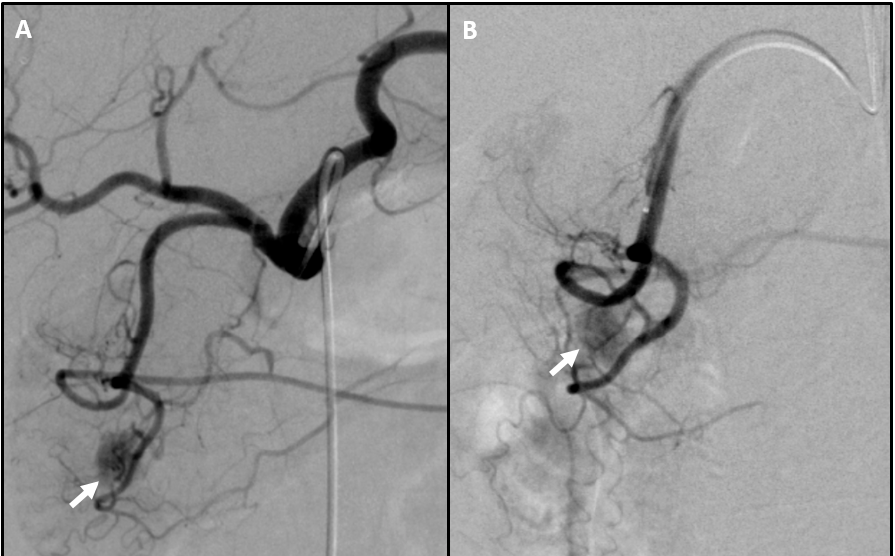
Figure 6. Hypervascular insulinoma on arteriogram. ( A ) Celiac arteriogram after selection with a Sim 1 catheter revealing conventional anatomy and a hypervascular insulinoma (arrow) in the territory of the gastroduodenal artery. ( B ) Sub-selective gastroduodenal arteriogram with a Progreat catheter confirms hypervascular insulinoma (arrow). No corresponding enhancing lesion was present on pre-procedural CT or MRI.